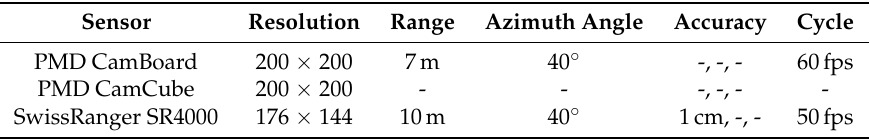
Table 3. Time-of-flight